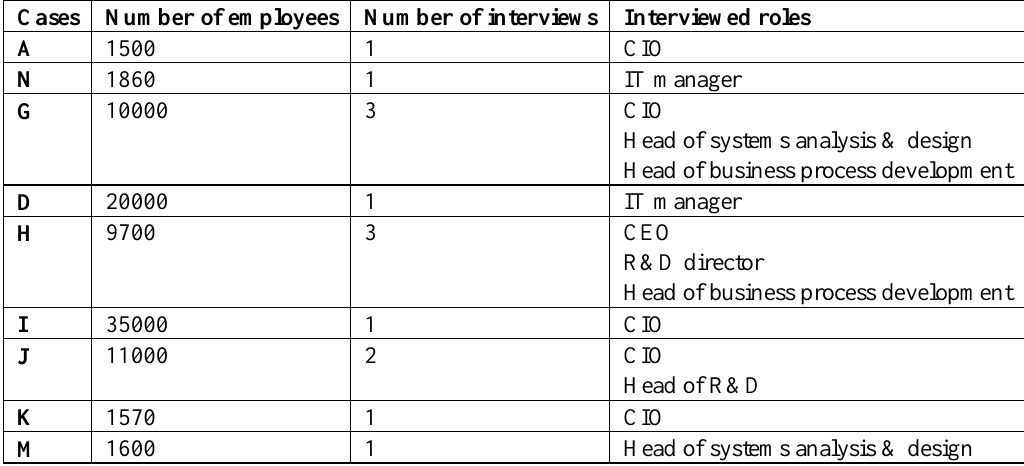
Table 1. Information about conducted interviews and the